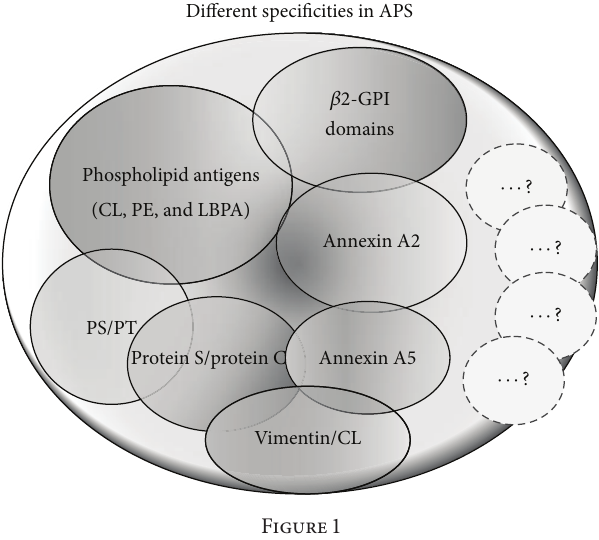
for diagnosis of immunological disorders, contributing to a better efficiency and accuracy in the diagnosis of autoim- mune diseases. The new diagnostic approaches should point out the risk stratification of the disease, taking into account first the potential combinations/panels of available aPL tests, including the issues of different entities of “seropositive” APS, “seronegative” APS, and non-APS aPL-positivity. This can be achieved also thanks to the various technologies that allow us to identify “new” epitopes, revealed through the typology of antigen presentation (Figure 1). Moreover, it will allow us to review new treatment strategies for APS that may target different pathways of coagulation and